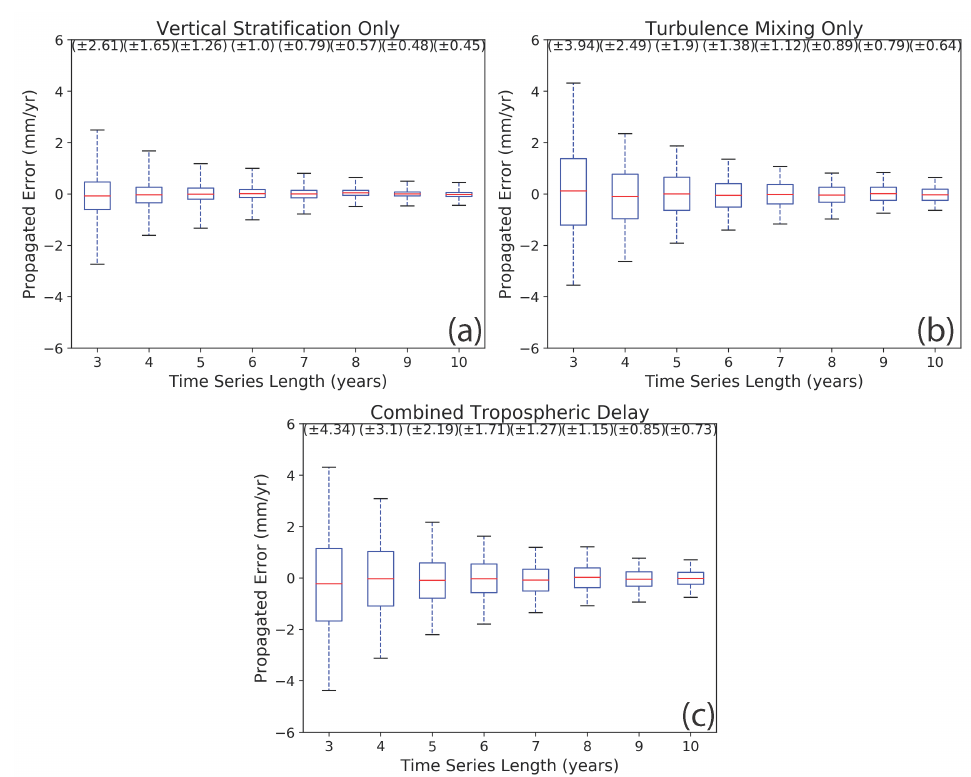
Figure 7. Velocity distributions as a function of time-series length for a 35-day acquisition interval: the blue boxes show the 68% confidence interval, the red lines represent the mean, and the extent of the whiskers shows a 95% confidence interval of the distribution. The values in brackets on the top show the calculated 2 σ distribution of the propagated error in millimeter per year for each time-series length. ( a ) The distribution of propagated error with vertical stratification phase delay only, ( b ) the distribution of propagated error with turbulence mixing delay only, and ( c ) the distribution of propagated error in the case of the combination of both phase